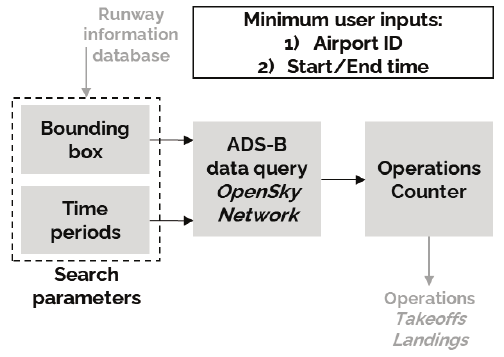
Figur e 1. Th e developed algorithm requires the user to select an airport and a time frame, and outputs the number of takeoff s and landings at all runways of the selected airport during that time. Th e operations required to query the OpenSky Network (all functions before the Operations Counter function) are depicted in Figure 2. Pseudocode for the Operations Counter function is provided in Figure 4